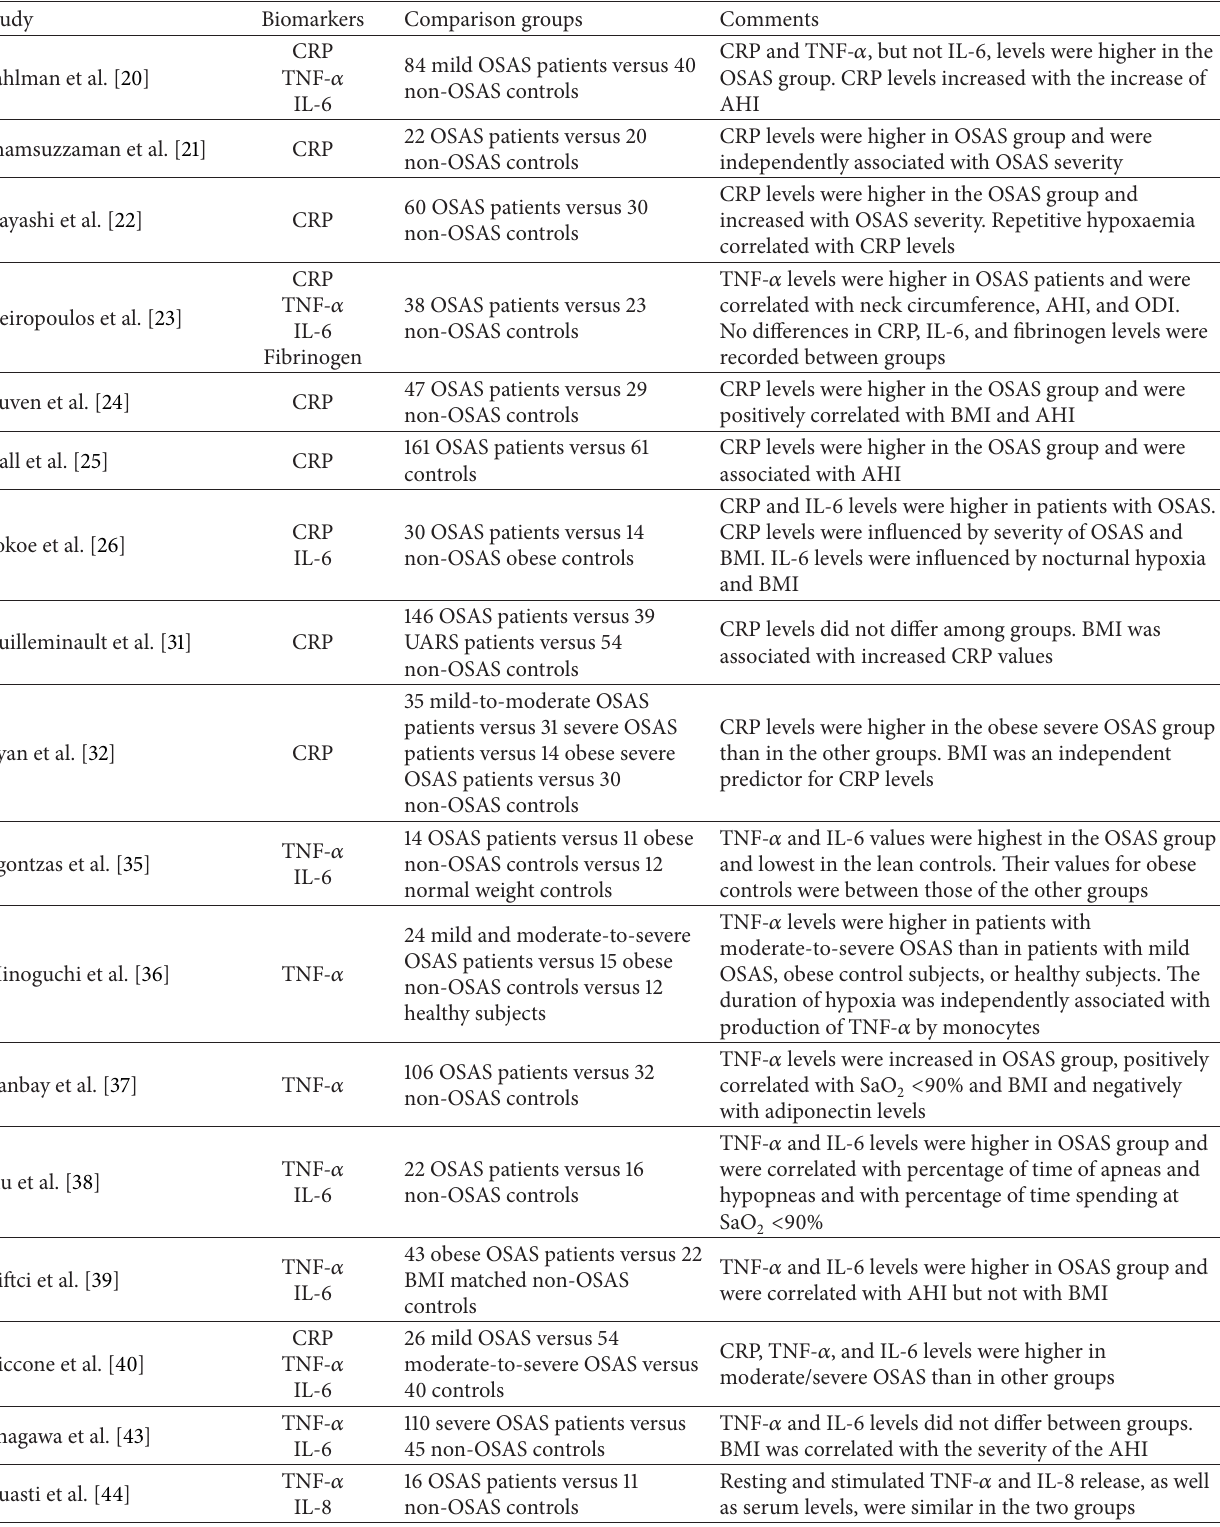
Table 1: Studies assessing inflammatory biomarkers in obstructive sleep apnea